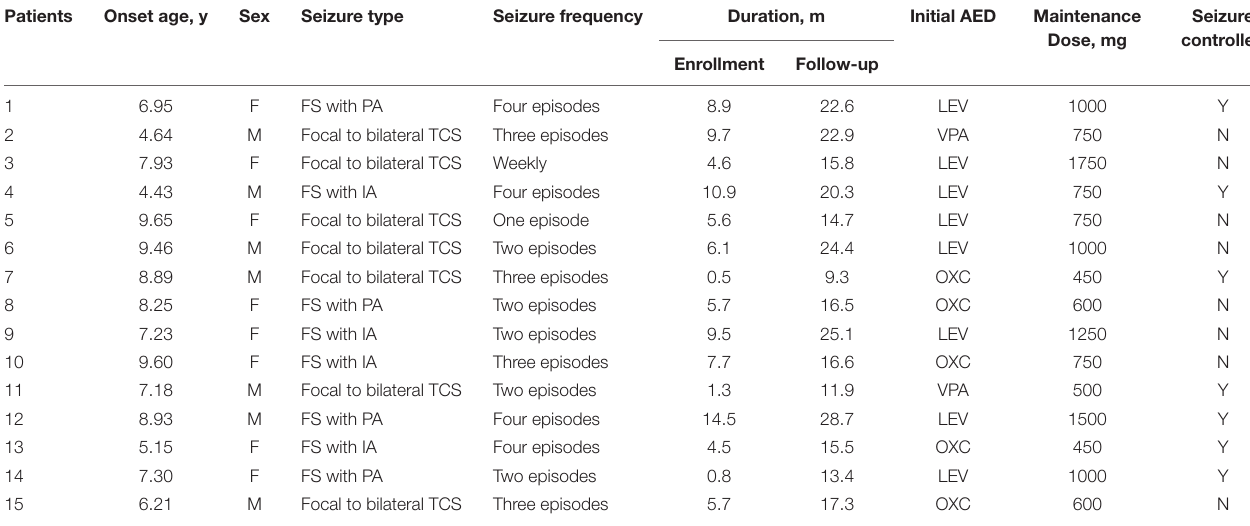
TABLE 1 | Demographic and clinical characteristics of the patients. Patients